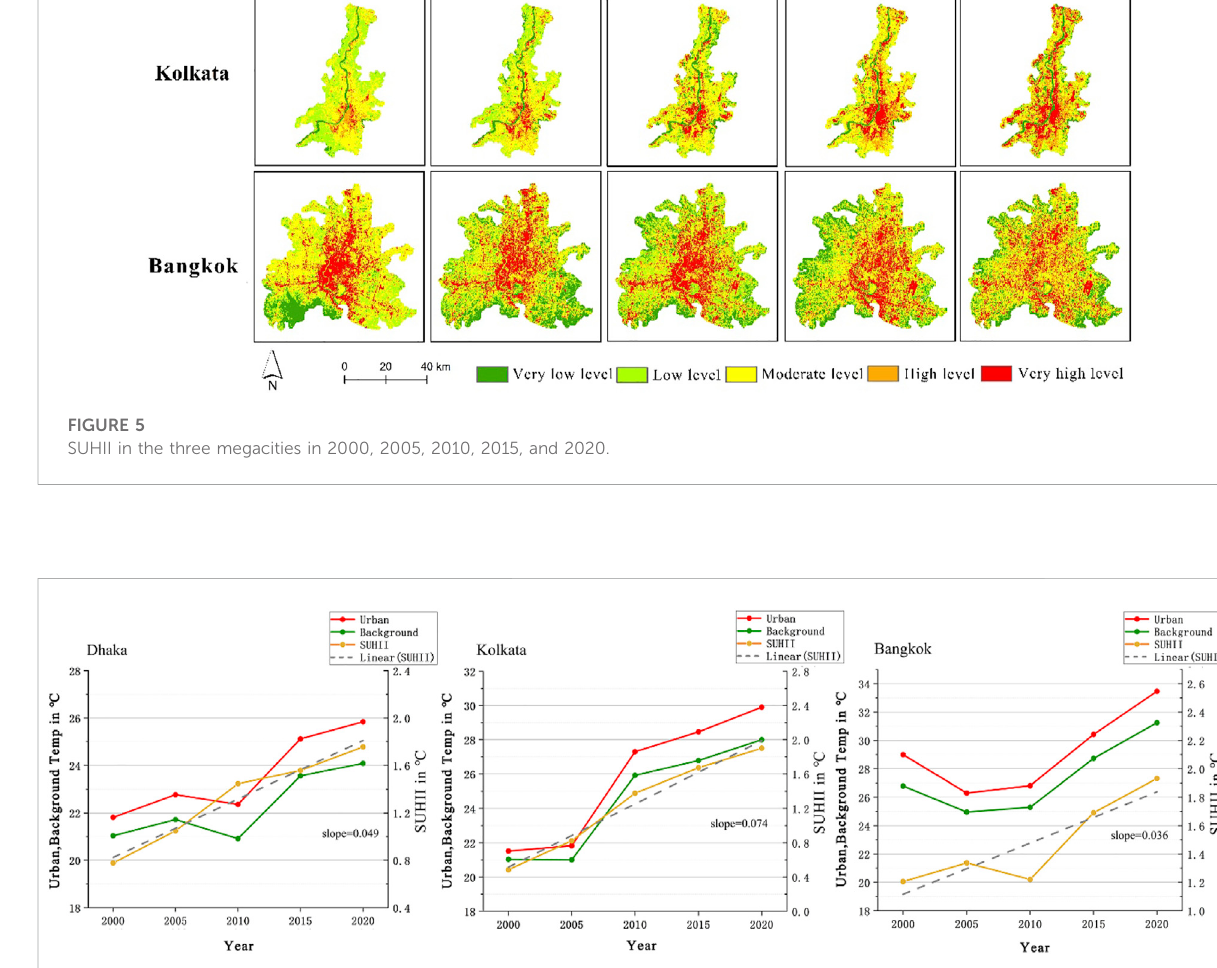
FIGURE 6 Temporal variation of SUHII in the three megacities from 2000 to